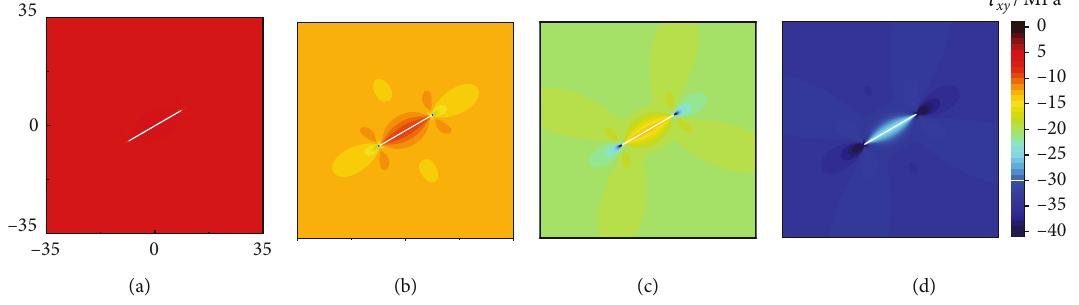
Figure 24: The contour plot of τ around the crack: (a) λ = 0 : 6 , Δ a / a = 0 : 33 ; (b) λ = 0 : 4 , Δ a / a = 0 : 50 ; (c) λ = 0 : 3 , Δ a / a = 0 : 67 ; and (d) λ xy = 0 : 2 , Δ a / a = 1